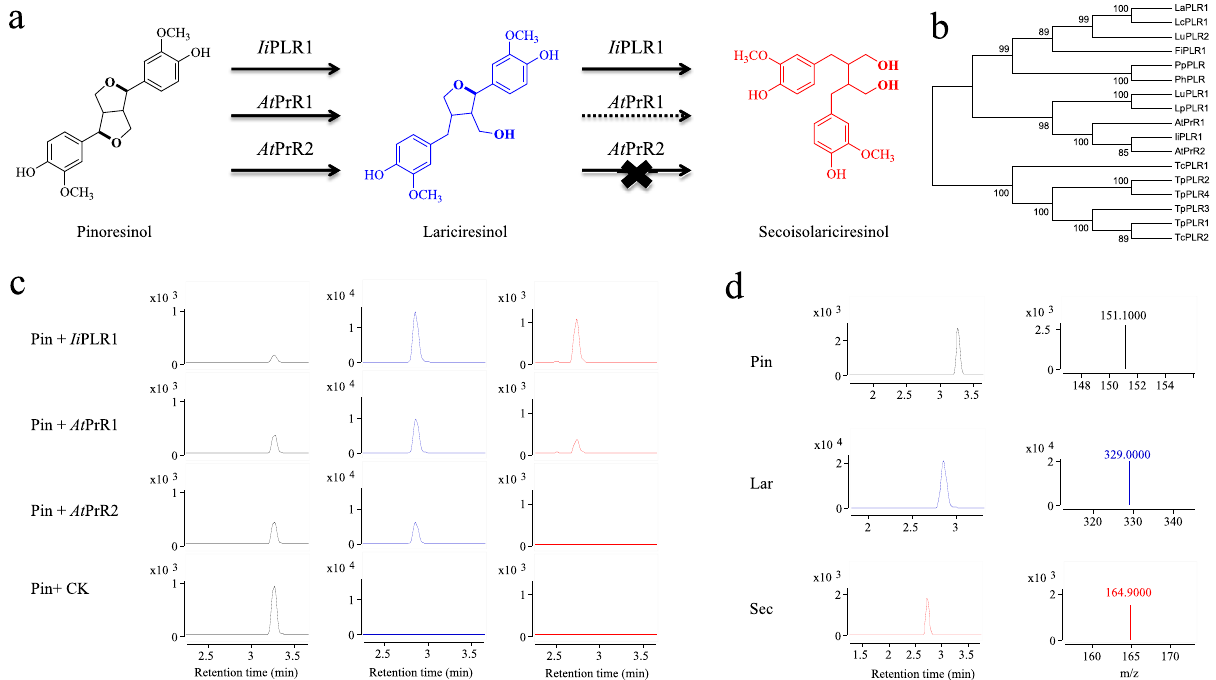
Fig. 1 Biochemical assays for Ii PLR1 and At PrRs function. a Ii PLR1 ef fi ciently catalyzes the conversion of pinoresinol into lariciresinol and also catalyzes the conversion of lariciresinol into secoisolariciresinol. In contrast, At PrR1/2 exhibit a substrate preference for pinoresinol, yet exhibit only weak activity ( At PrR1) or no activity ( At PrR2) for lariciresinol. b Phylogenetic tree of PLRs/PrRs from different species. c Conversion of pinoresinol into lariciresinol and then into secoisolariciresinol by recombinant Ii PLR1, At PrR1, and At PrR2. The reaction products were analyzed by LC-MS. d Chromatograms for pinoresinol, lariciresinol, and secoisolariciresinol are denoted in black, blue, and red,